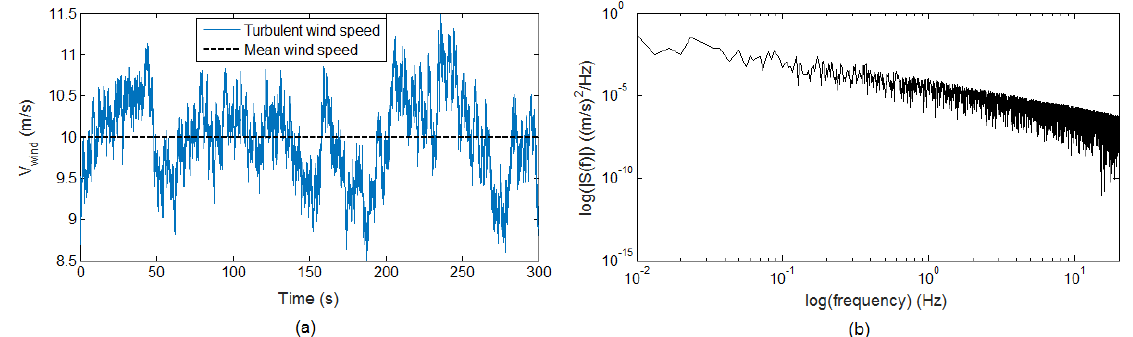
Figure 15. Turbulent wind profile generated using QBlade: ( a ) wind speed fluctuations at the nacelle height; ( b ) PSD of the wind speed at nacelle height.